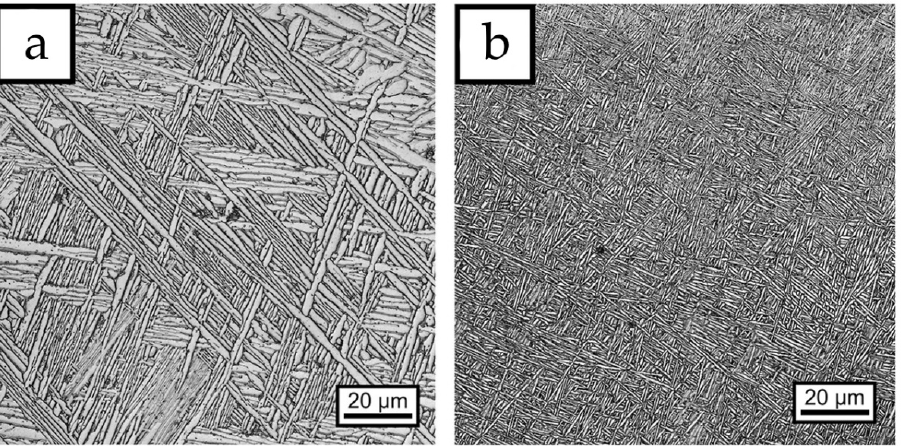
Figure 3. Microstructure of the additive Ti ‐ 6Al ‐ 4V printed with ( a ) low and ( b ) high heat dissipation intensity (adapted from [45]).